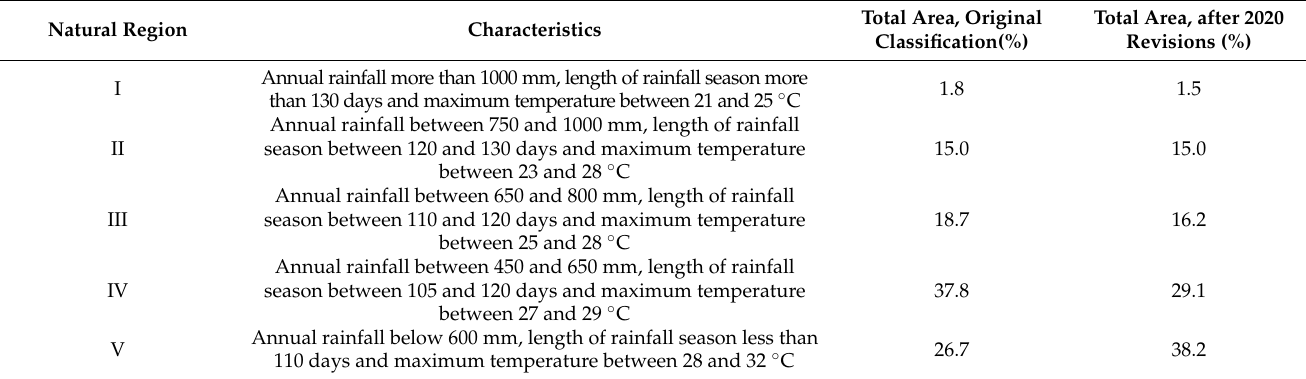
Table 1. Climatological description of natural regions in